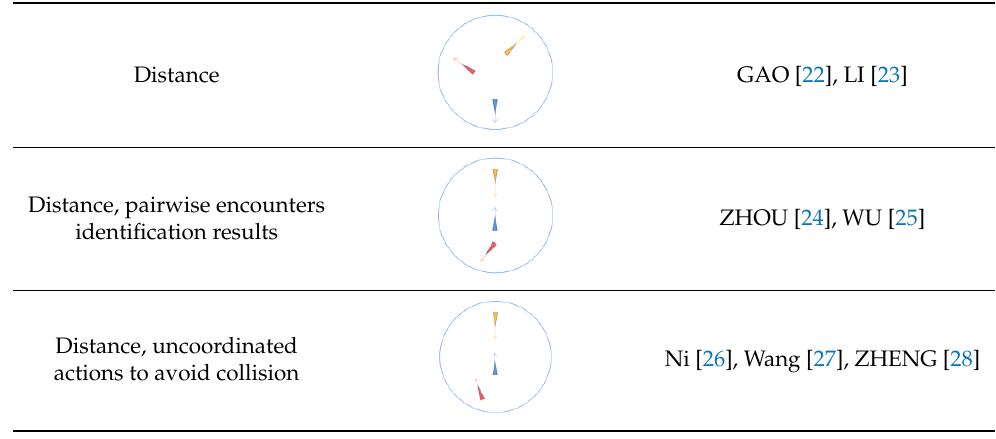
Table 2. Three kinds of multi-ship encounter situations definitions.